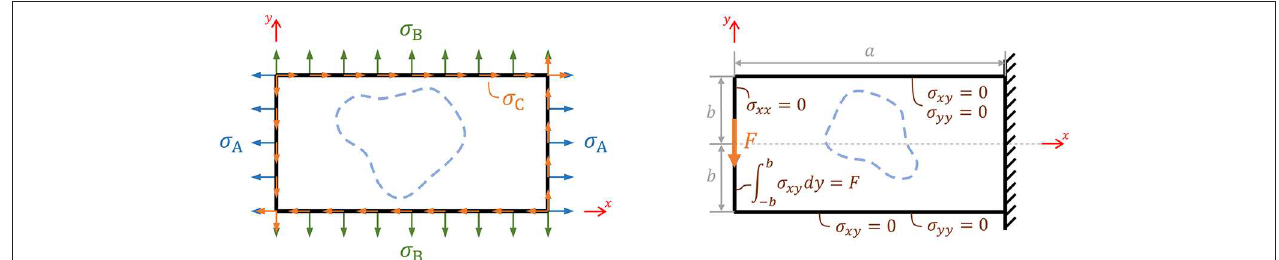
FIGURE 1 | Left: A rectangular body with uniformly distributed loads. Right: A rectangular beam with an end